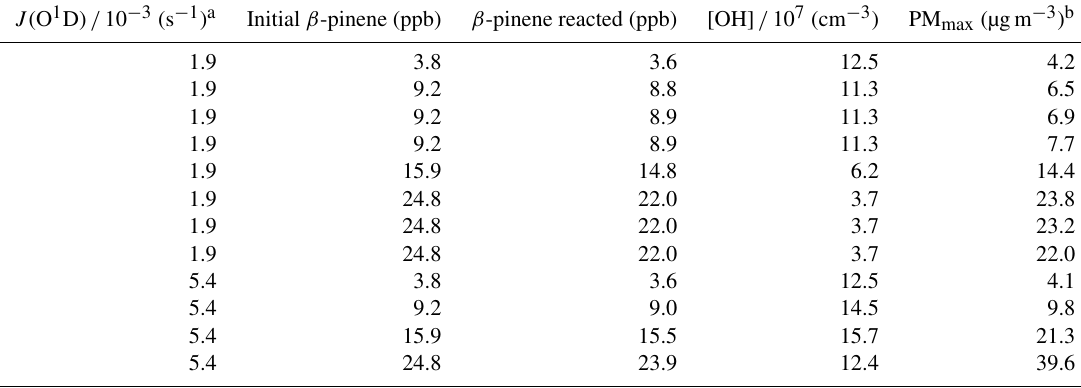
Table 2. Experimental conditions and results for β -pinene photooxidation experiments at two OH levels.